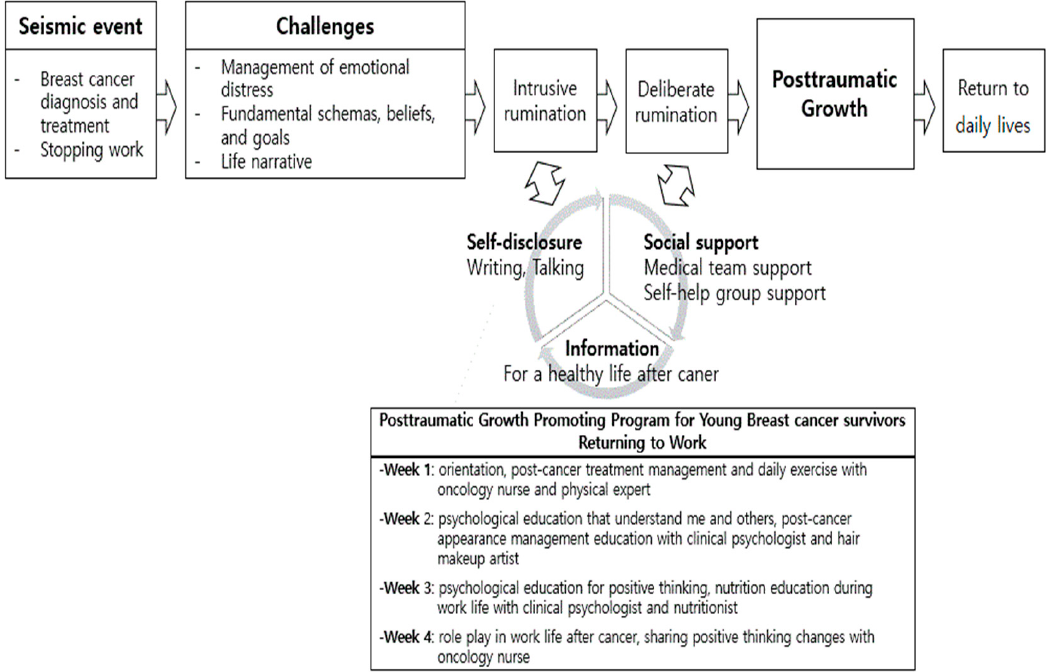
Figure 1. Contents of post-traumatic grow program on young breast cancer patients.